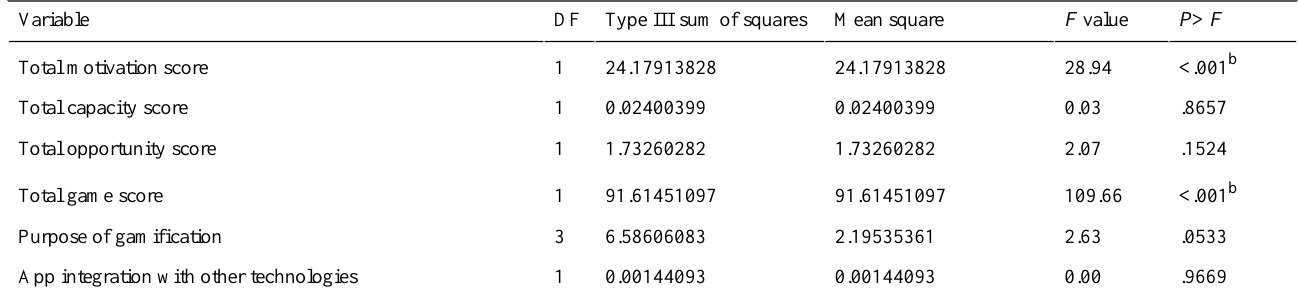
Table 5. Regression analysis, for total gamification components (N=132). a